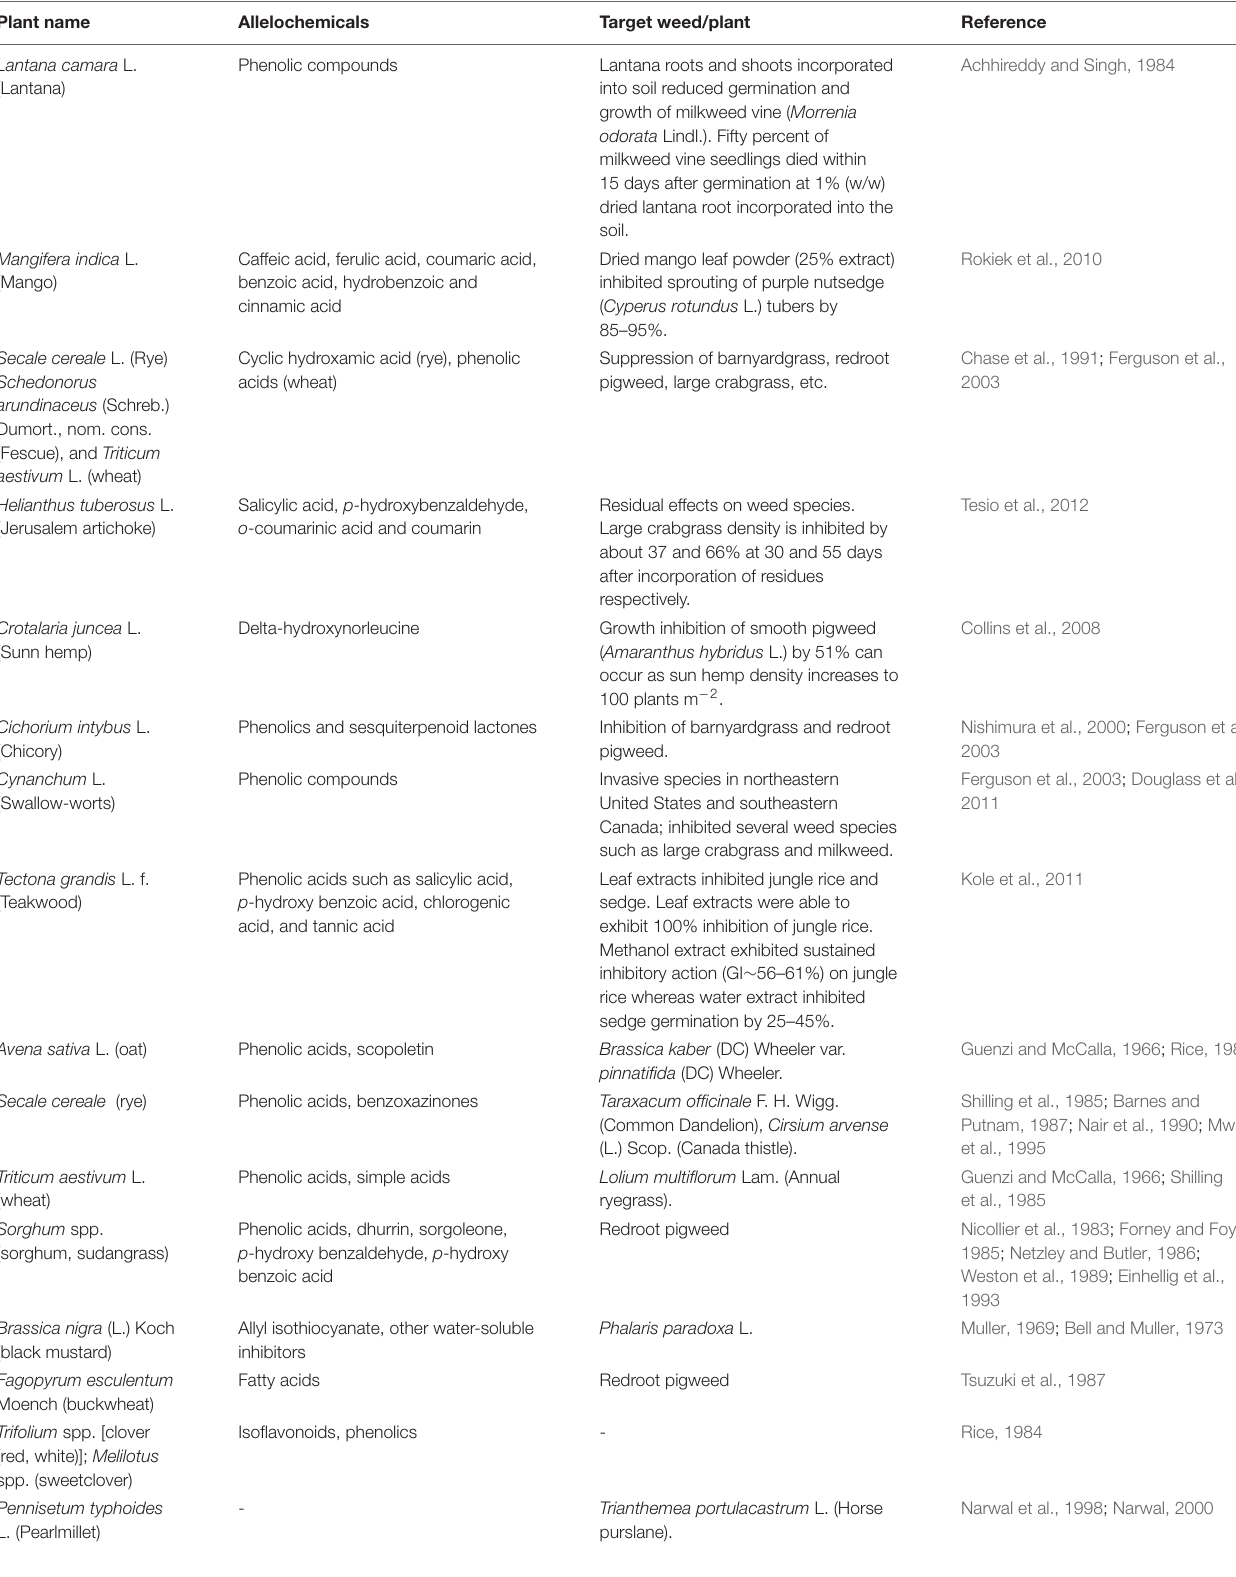
TABLE 1 | Examples of allelopathic effect of some common plants on weed suppression (partially adapted from Ferguson et al.,